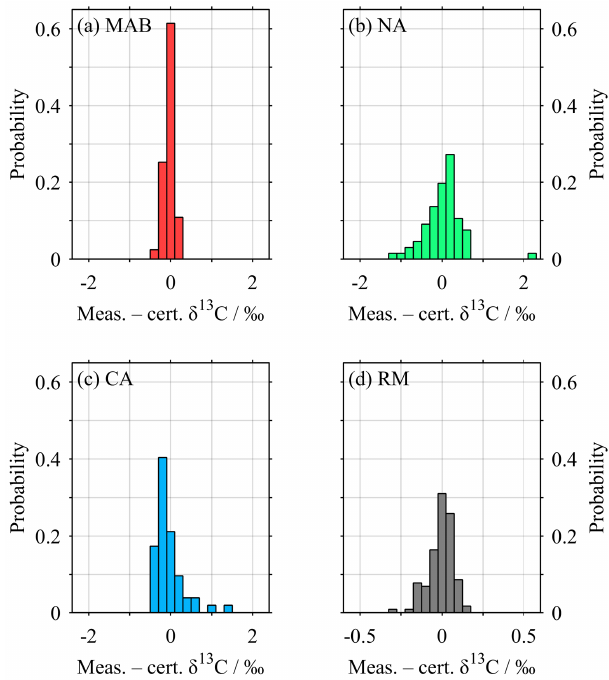
Figure 10. Histograms of offset of all standards and RM from their certified values (Table 1). Mean ± SD are (a) MAB, − 0.03 ± 0.13‰; (b) NA, + 0.02 ± 0.46‰; (c) CA, − 0.04 ± 0.35‰; and (d) all RM, − 0.01 ± 0.08‰. “Certified” values for RM are our final values, 1.15‰ for RM141 and 1.27‰ for RM144 (Table 3). Note the increased horizontal resolution in (d)